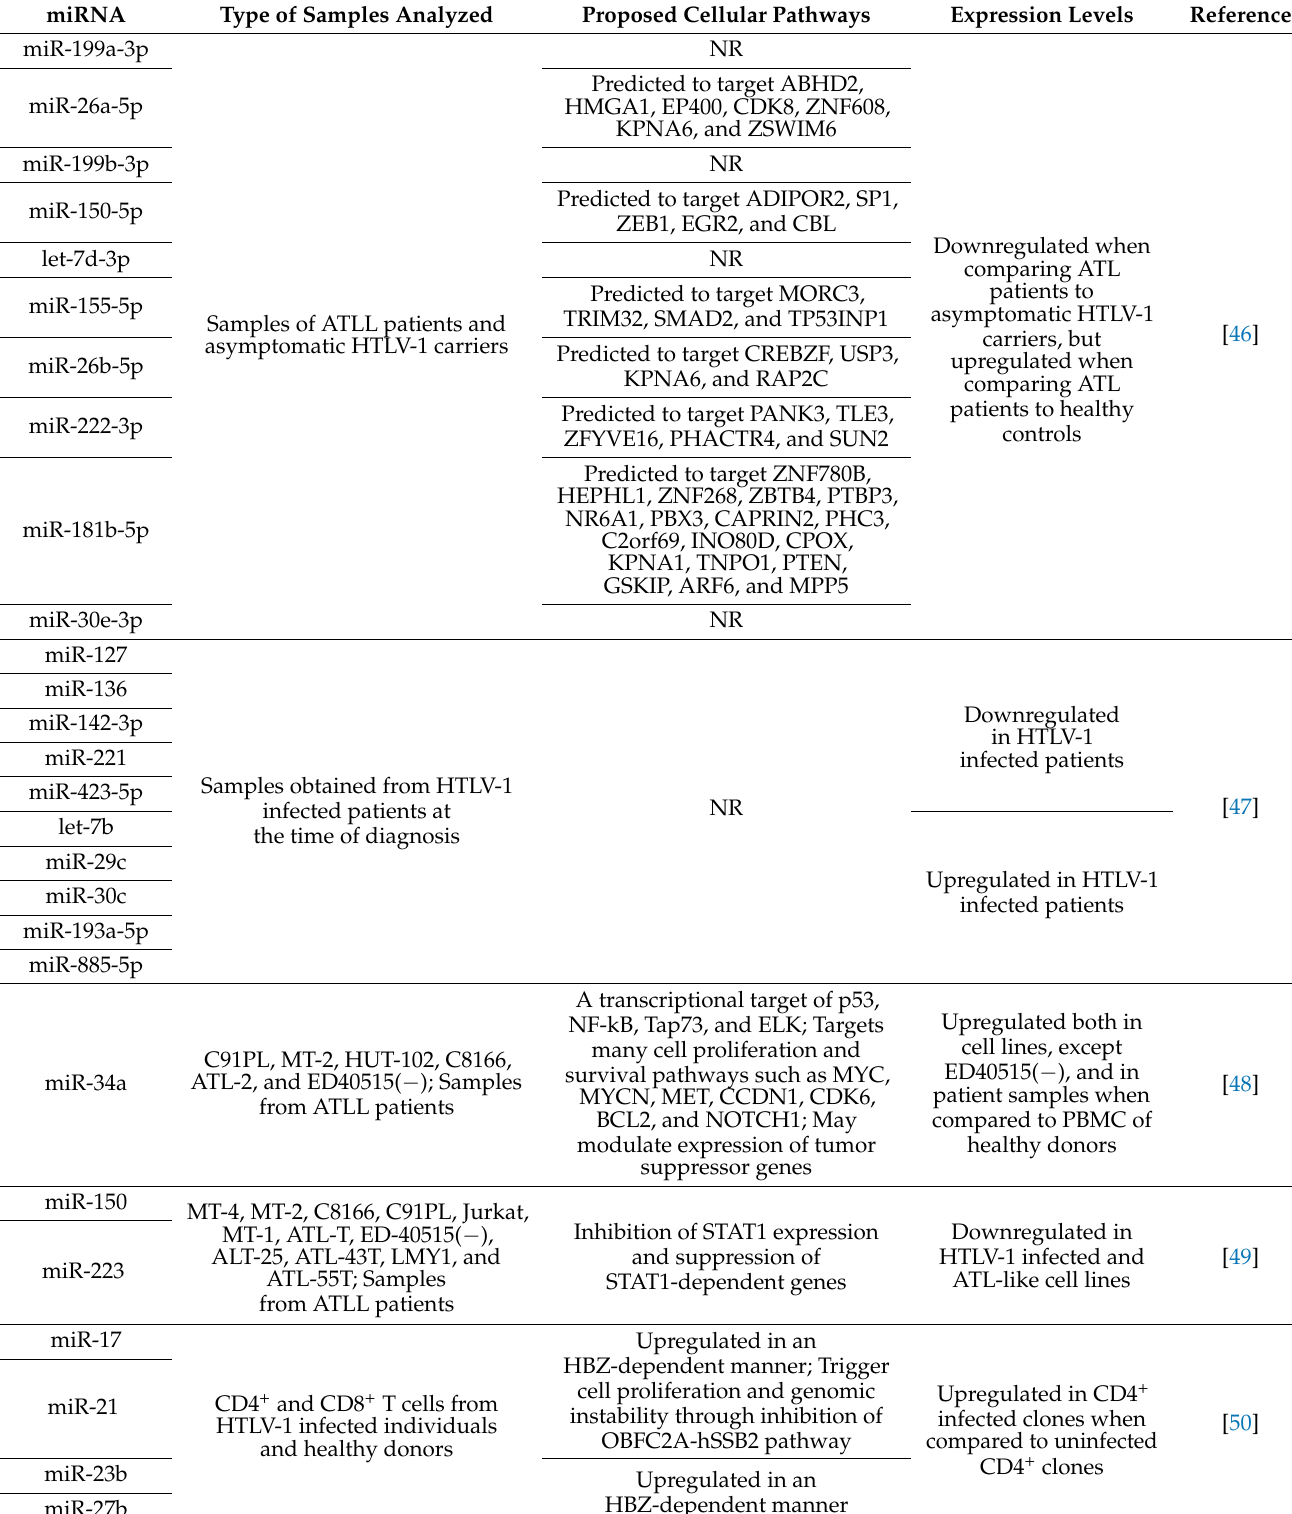
Table 1. Studies describing altered expression of miRNAs after HTLV-1